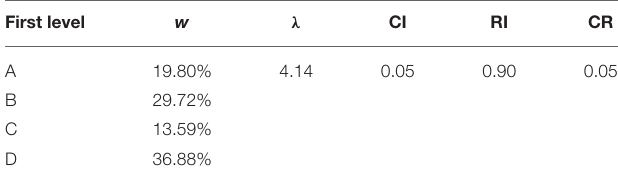
TABLE 5 | The weight coefficients of the four first grade indicators. First level